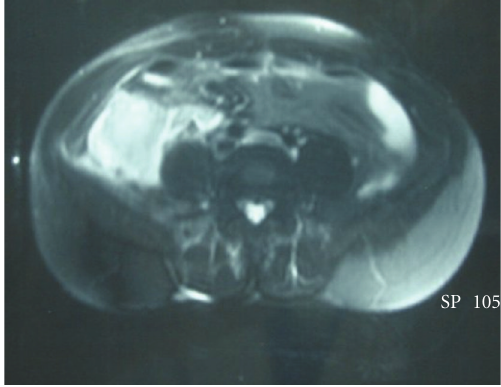
Figure 2: MR characteristics of the retroperitoneal mass.